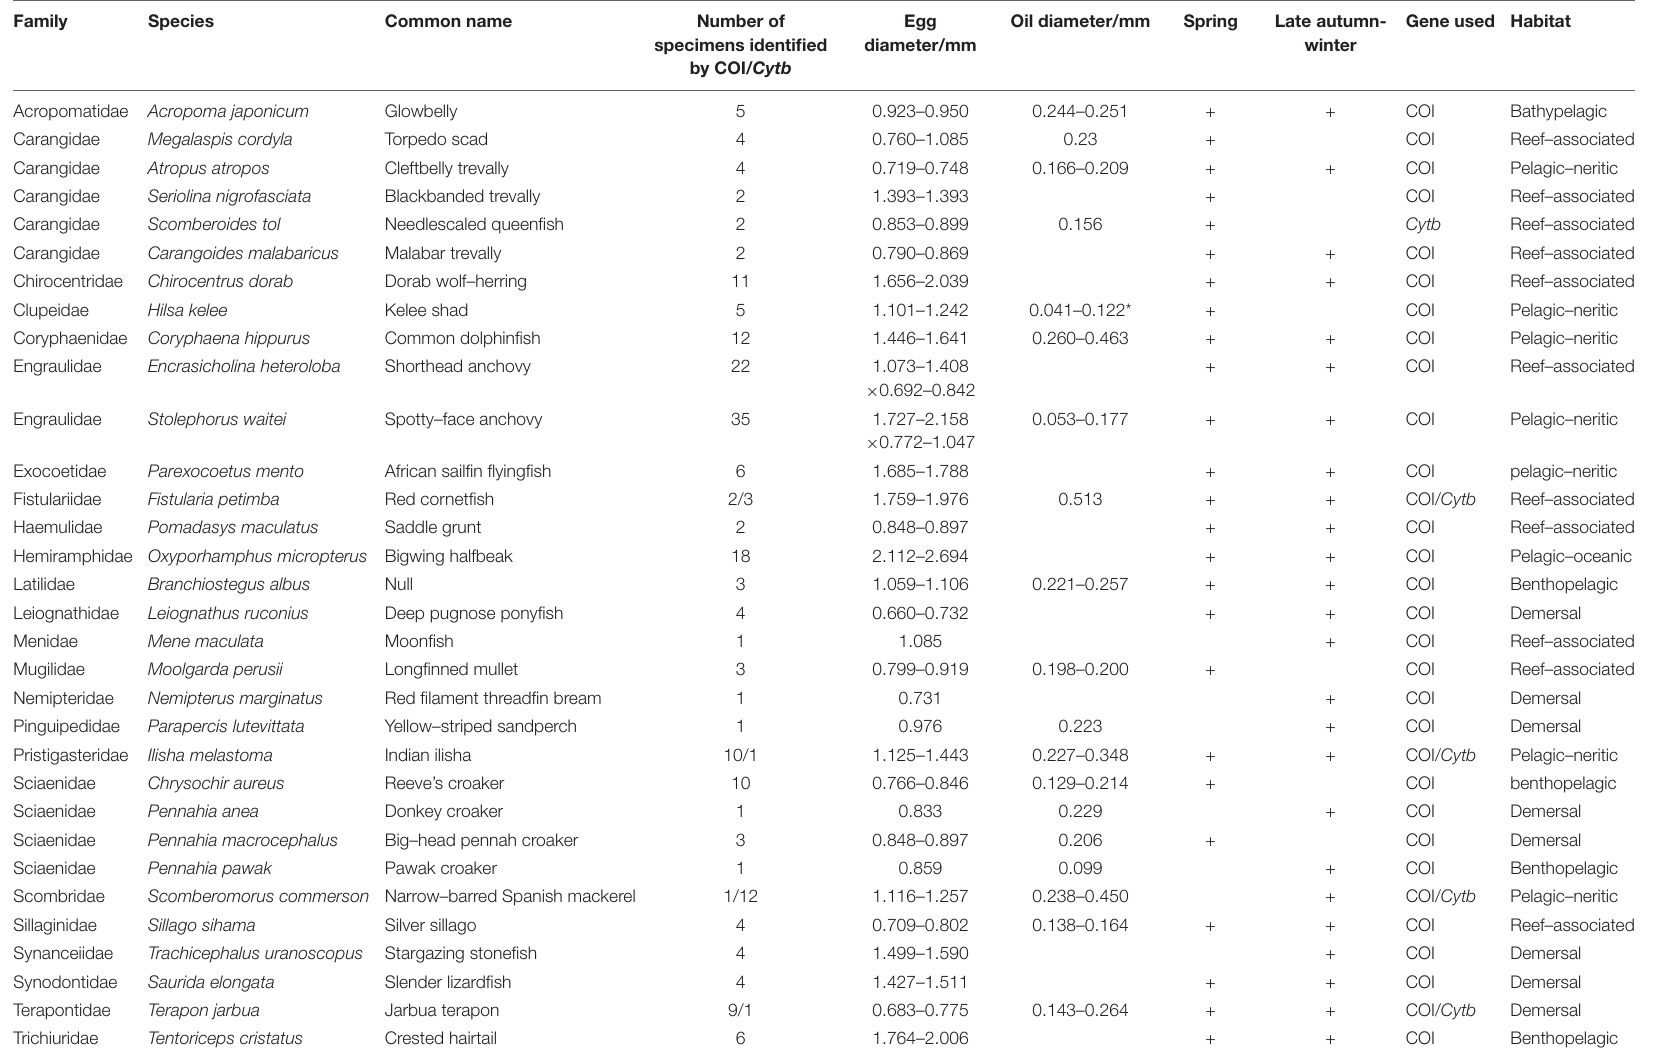
TABLE 1 | The fish eggs identified in species level using molecular methods.